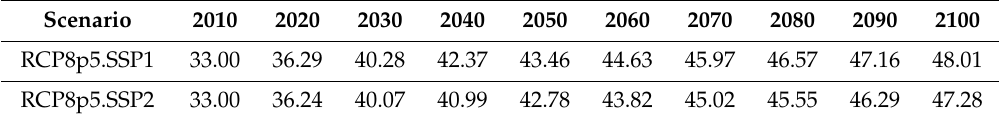
Table A3. Industrial roundwood harvest assortments—Sawlogs (millions of m 3 / year, under bark).